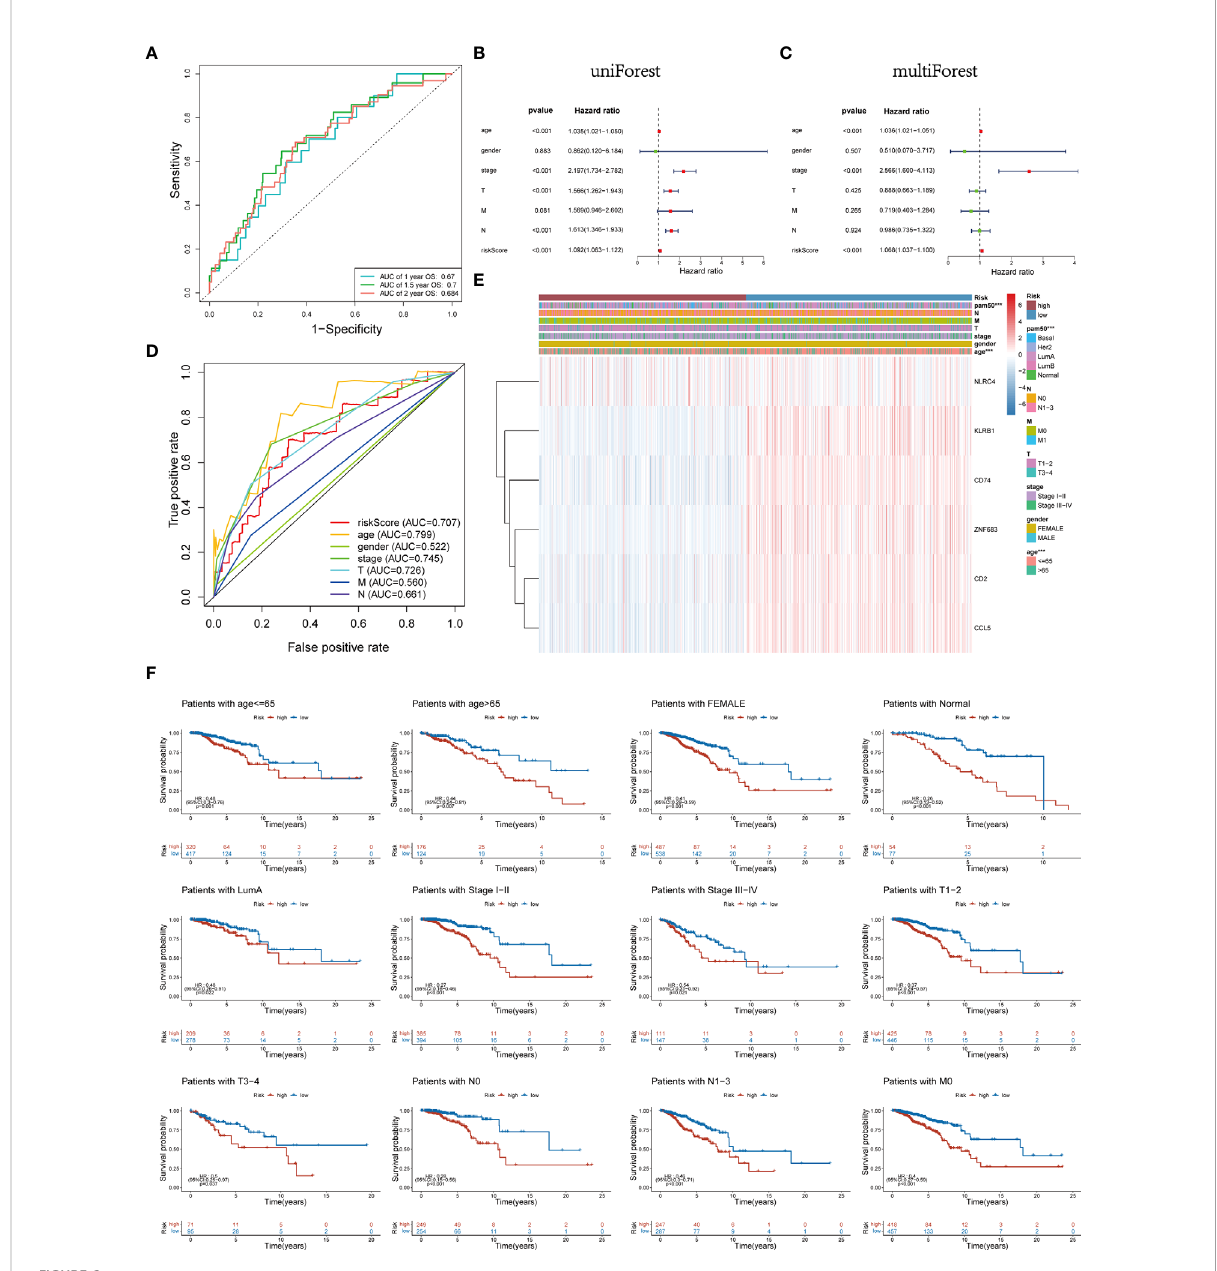
FIGURE 6 (A) Time-dependent ROC curve of 1, 1.5, and 2 years for survival prediction model. (B, C) Univariate and multivariate Cox regression analyses proved risk score was deemed to be an independent prognostic predictor. (D) ROC curves for the risk score, age, gender, stage, T, M and N. (E) Heatmap of the association between the expression levels of the six Pyro-GPS and clinicopathological features in TCGA dataset. (F) Strati fi cation analysis based on clinicopathological features to compare survival difference in high-/low-risk subtypes. ROC, receiver operating characteristic; Pyro-GPS, pyroptosis-related genes prognostic signature; TCGA, The Cancer Genome Atlas; ***p <